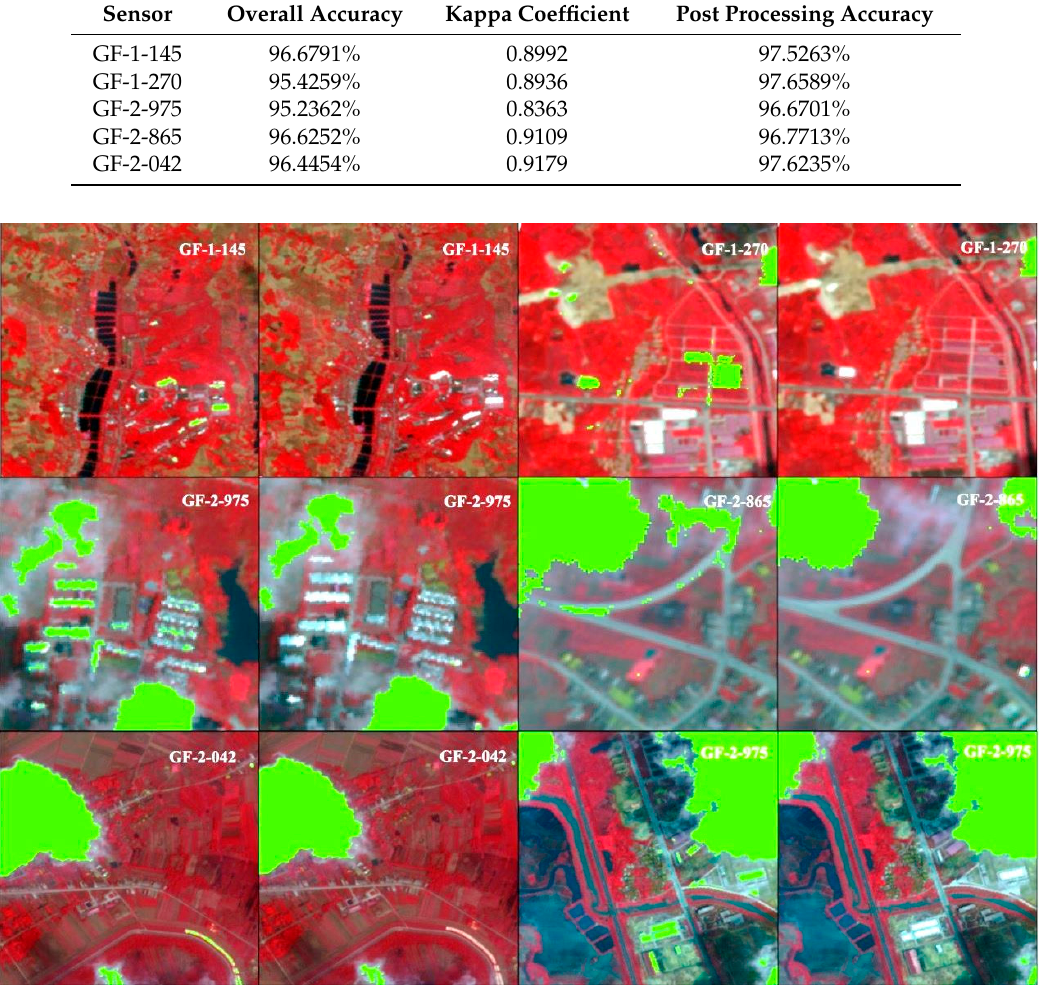
Figure 8. Rough cloud detection and object-oriented post-processing results for five GF-1/2 images (the fluorescent green regions in the picture represent our cloud test results). Table 4. Rough cloud detection accuracy and object-oriented post-processing accuracy for five GF-1/2 images.